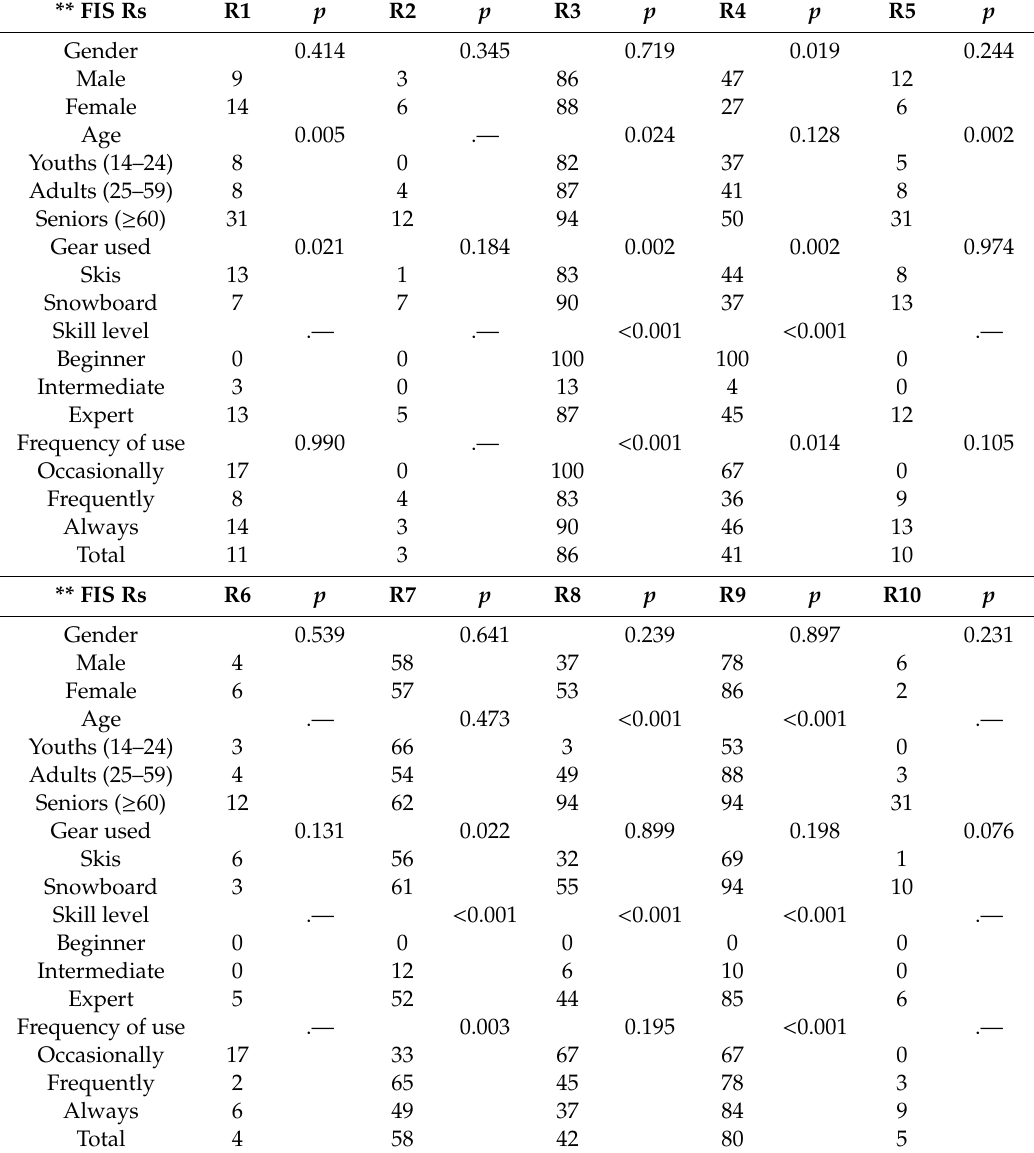
Table 7. Actual active knowledge of existing rules for SPs among survey participants